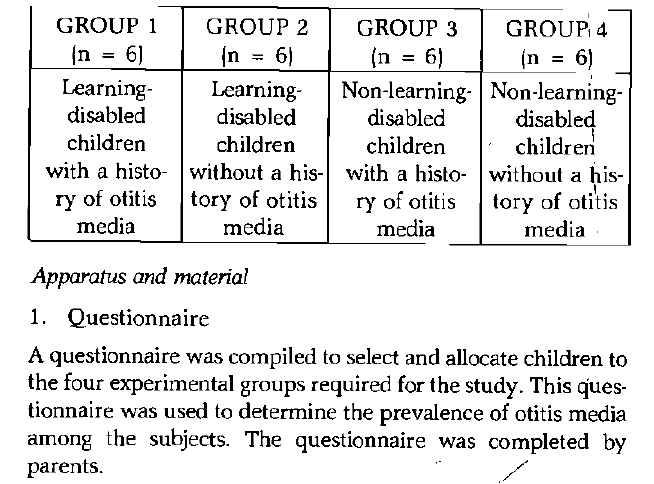
Table 1: Description of experimental groups (n =